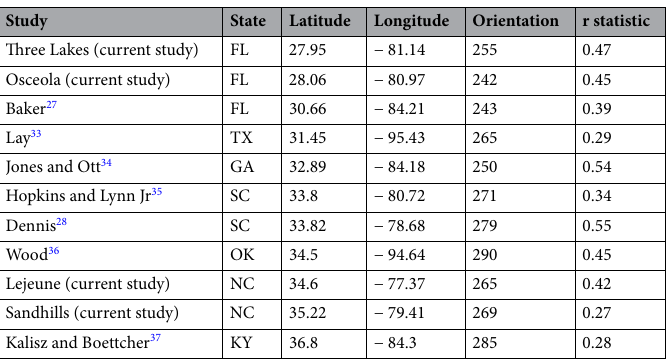
Table 1. Collection of literature data and data presented in the current study sorted by latitude. The mean orientation, mean vector length (r), latitude, and longitude in decimal degrees are given for each data set. For all tests of non-random orientation in all populations, p ≤